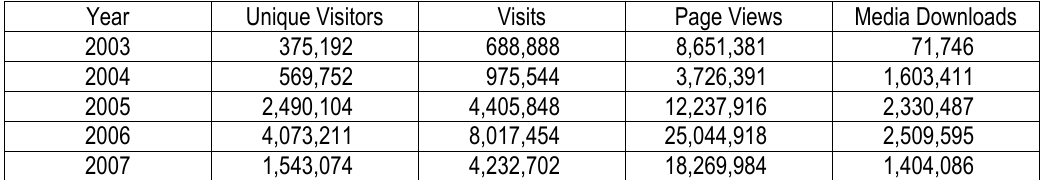
Table 3. Users’ Statistics 2003-2007 (from January to July) Year Unique Visitors Visits Page Views Media